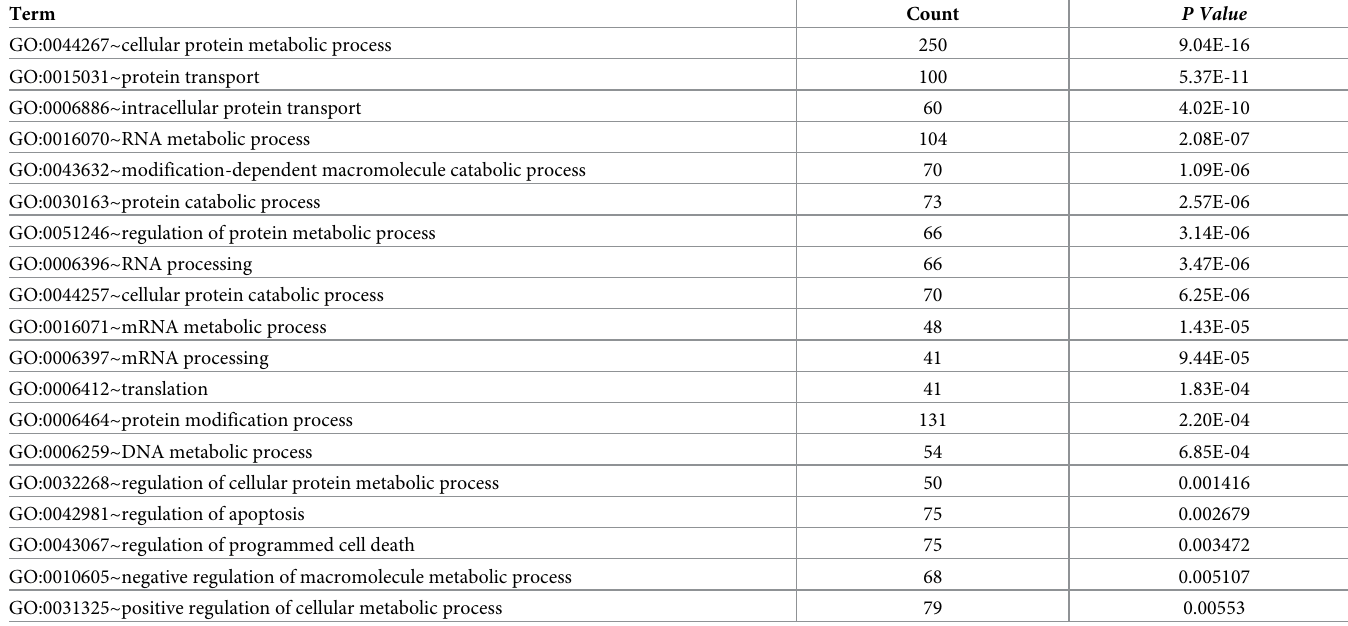
Table 2. GO enrichment using up-regulated